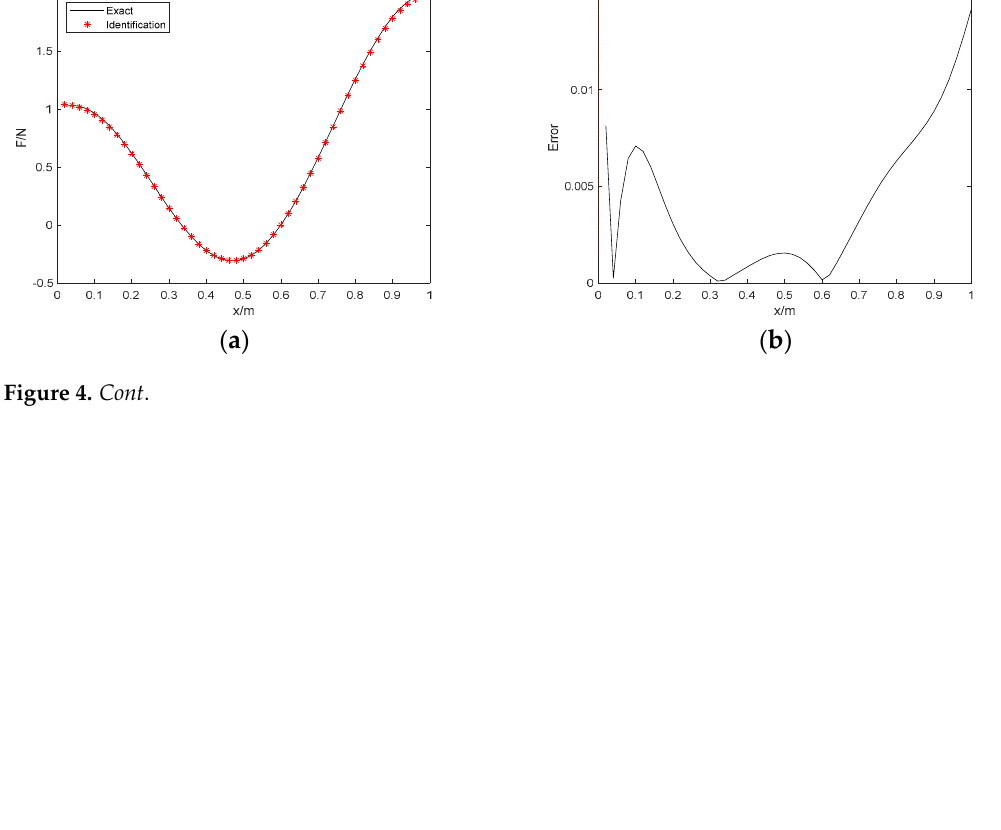
Figure 3. The identification results with 1% noise. ( a ) Proposed method; ( b ) identification error; ( c ) Tikhonov with L − curve regularization; ( d ) identification error; ( e ) Tikhonov with GCV regulariza- tion; ( f ) identification error. Table 2. Identification error in Example 1.